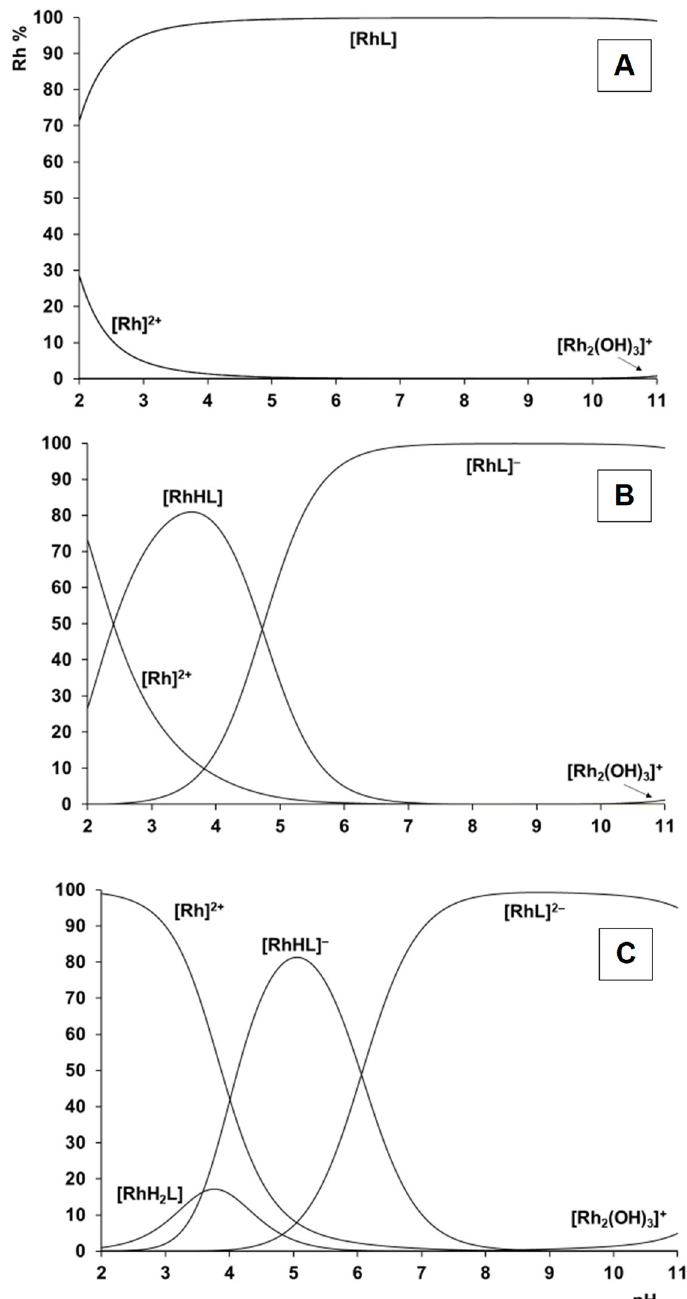
Figure 3. Concentration distribution curves calculated for the [( η 5 -Cp*)Rh] 2+ –Ida 2 − ( A ), –IdaP 3 − ( B ), and Ida2P 4 ‒ ( C ) systems at a 1:1 ratio (c Ru = 3 mM, I = 0.20 M KCl). “Rh” stands for the [( η 5 -Cp*)Rh] 2+ entity.